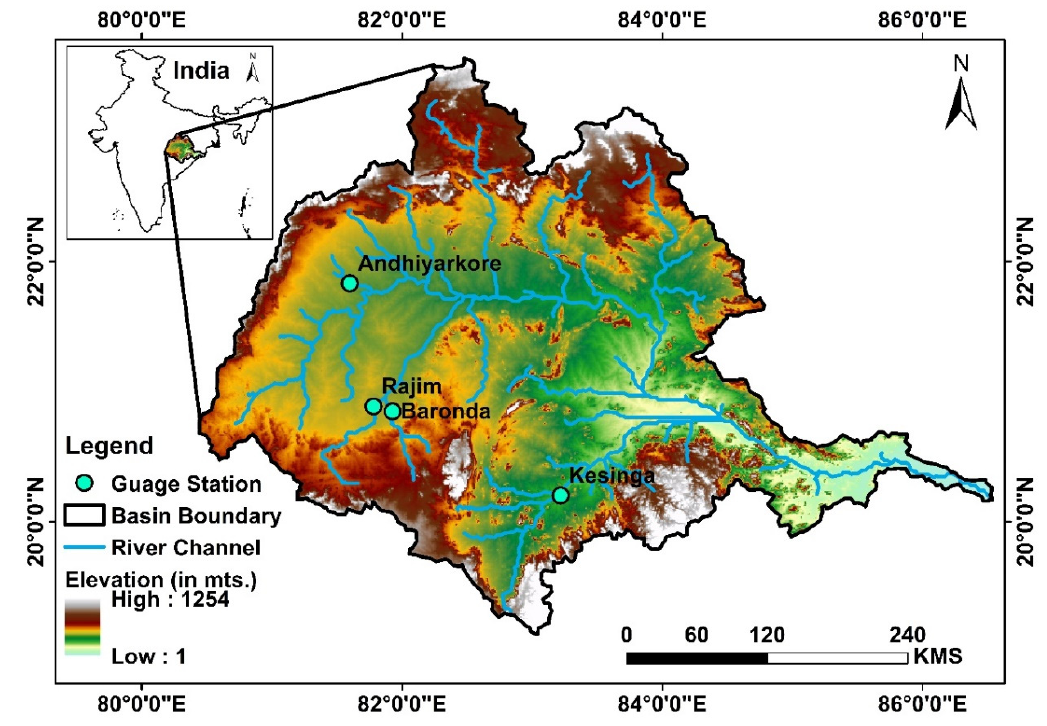
Figure 1. Location map of Andhiyarkore, Baronda, Rajim, and Kesinga streamgauge stations within the Mahanadi River basin.